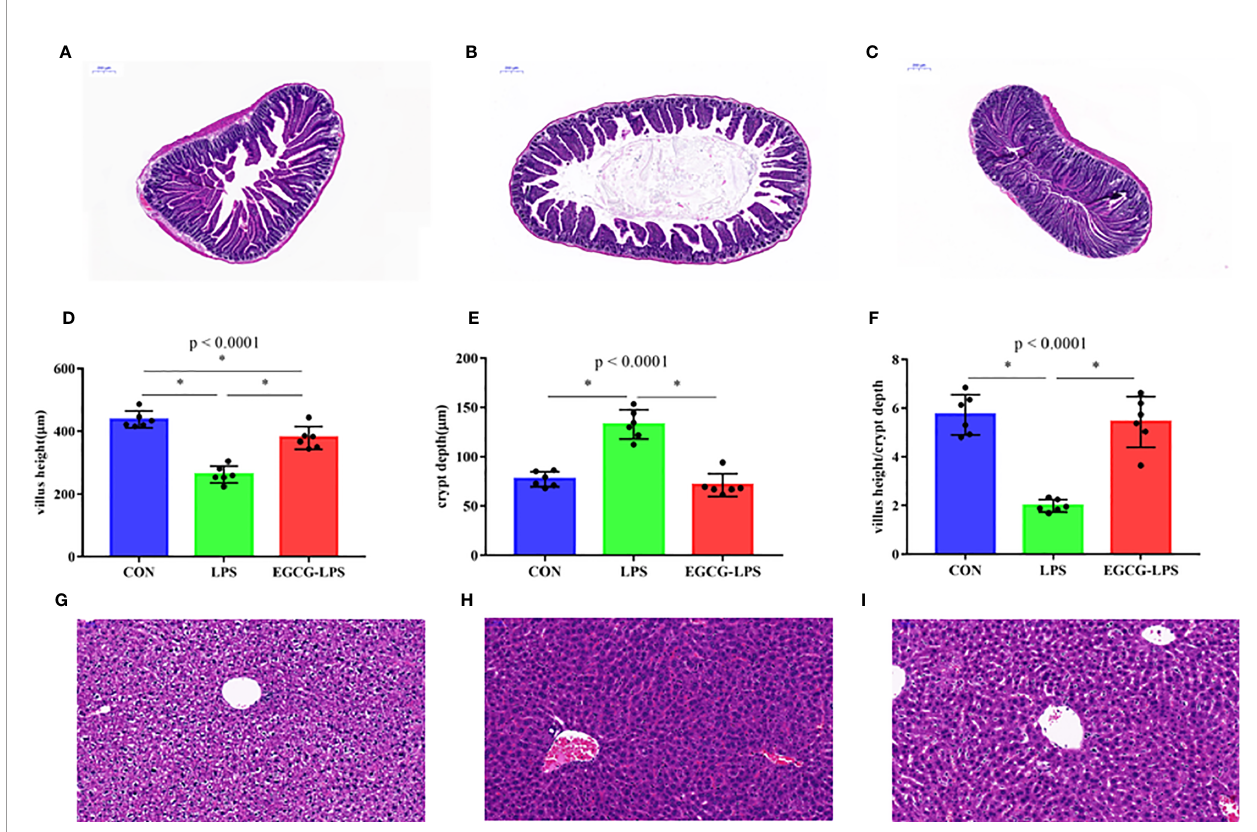
FIGURE 2 | The protective effect of intragastric administration of EGCG on jejunum tissue and liver tissue damage. Images of colon morphology in the CON (A) , LPS (B) , and LPS-EGCG (C) groups under 200× visual fi elds; villus height (D) , crypt depth (E) and villus height/crypt depth (F) in the three groups; Images of liver morphology in the CON (G) , LPS (H) , and EGCG-LPS (I) groups under 200× visual fi elds; Data are mean ± SD (n = 6) and analyzed by one-way ANOVA. “ * ” means that the horizontal line connects the p -value of the data between the two groups <0.05, and the “ P ” value in the fi gure represents the accurate value of p between the three groups of data, and some of the p values between the three groups are too small to be expressed as p